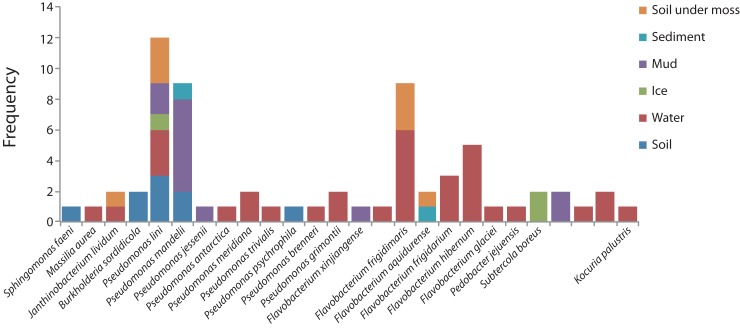
Frequency of phylotypes isolated by habitat.Differentiation based on membrane permeability showed that 21 of 26 phylotypes were comprised by Gram-negative strains (i.e. phyla Proteobacteria and Bacteroidetes), and 5 of 26 by Gram-positive strains (i.e. all to phylum Actinobacteria) (S1 Table). Strains of Pseudomonas (n = 34), Flavobacterium (n = 22), and Arthrobacter (n = 3) were frequently isolated and identified at genus level, and belong to the phyla Proteobacteria, Bacteroidetes, and Actinobacteria, respectively (S1 Table). We compared the isolation source of strains from this study with strains representing their nearest phylogenetic relative (NPR) in the NCBI database. Forty two of 67 NPR have a non-Antarctic isolation source (S1 Table). However, 25 of 67 NPR were isolated from Antarctic or similar environments, specifically from habitats like mats, glaciers, seawater, freshwater, and marine sediments (S1 Table). Finally, identification of the different phylotypes showed that only 5 of them were recovered from two or more habitats (i.e. Janthinobacterium lividum, Pseudomonas lini, Pseudomonas mandelii, Flavobacterium frigidimaris, Flavobacterium aquidurense) (Fig 2). The most frequently encountered phylotypes were Pseudomonas lini, and Pseudomonas mandelii, which were found in 5, and 3 habitats respectively, from a total of 6 different analyzed habitats (Fig 2).